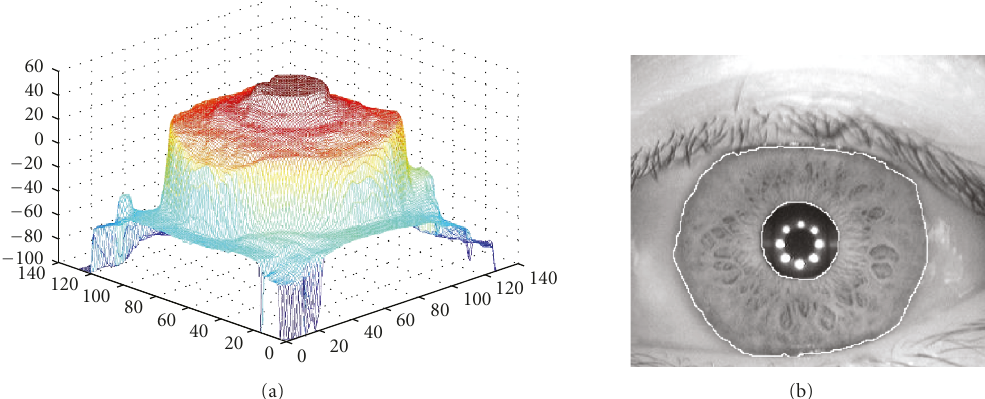
Figure 1: (a) Three-dimensional function of level set approach, (b) Result of application of the zero level set method to an iris image taken from CASIA-IrisV3.